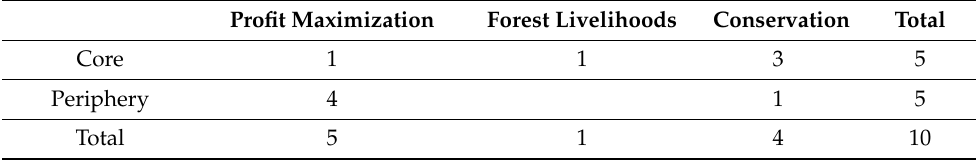
Table 5. Core beliefs and